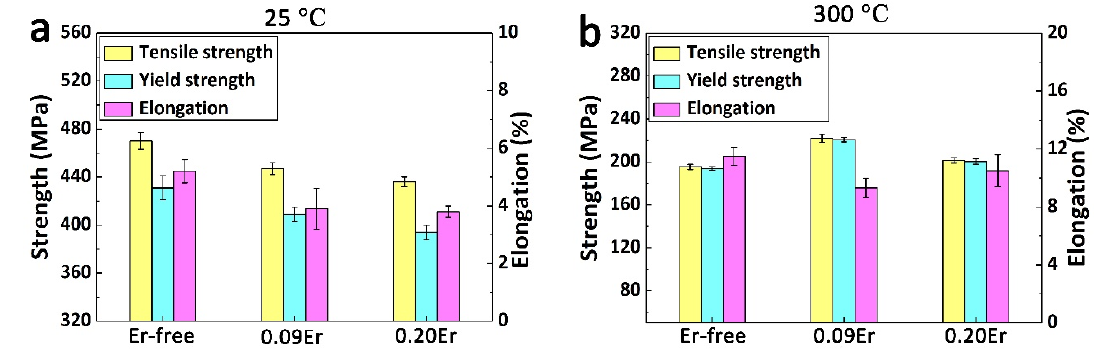
Figure 2. Tensile properties of studied alloys in T6 state at ( a ) 25 °C; ( b ) 300